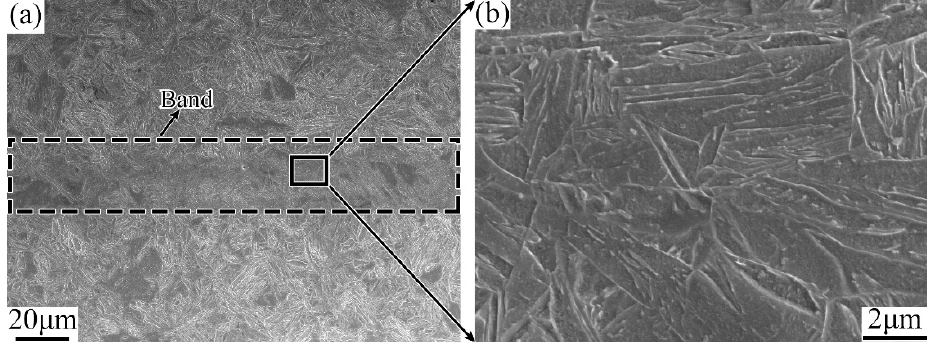
Figure 6. Lower ( a ) and higher ( b ) magnified SEM images of banded structure in as-quenching sample.